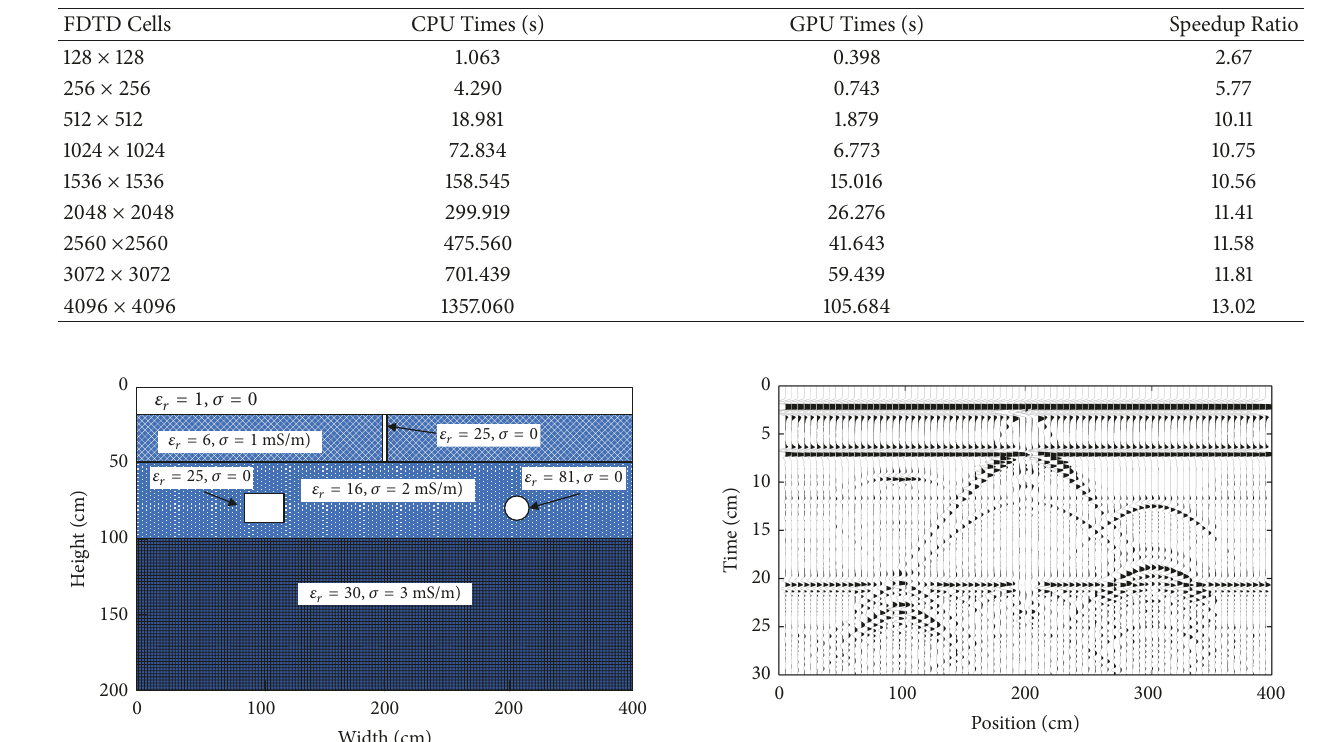
Table 1: Speedup ratio of the two methods.